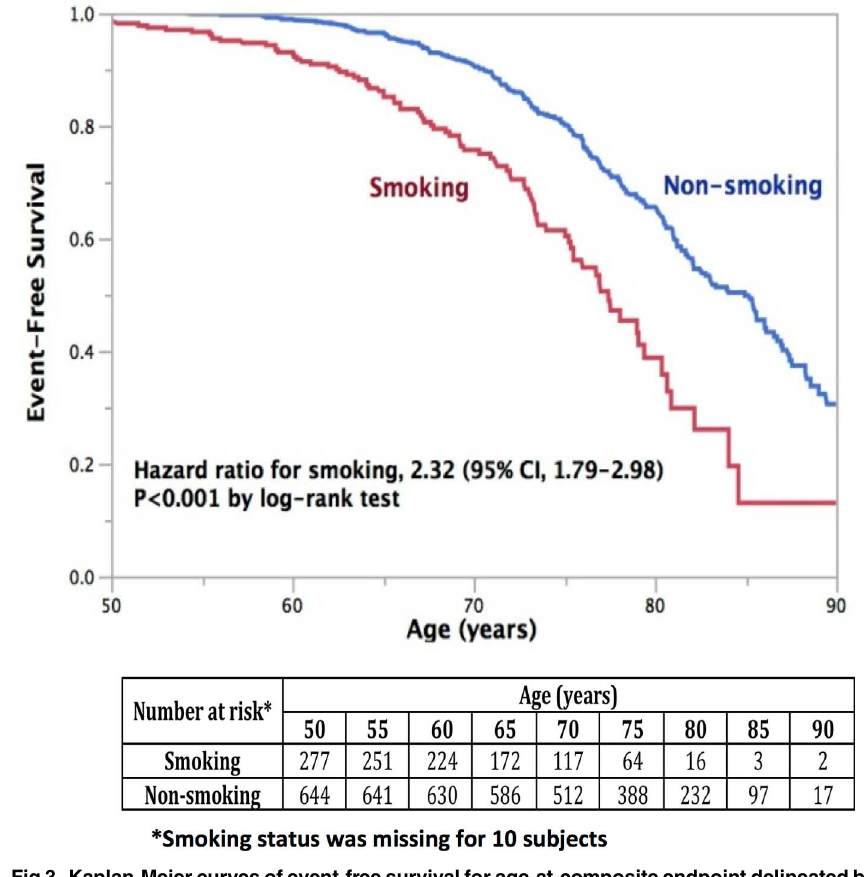
Fig 3. Kaplan-Meier curves of event-free survival for age-at-composite endpoint delineated by smoking status. The hazard ratio, assessedby log-ranktest for age-at-composite endpointdelineatedby smoking status, was 2.32 [1.79, 2.98], p < 0.001.